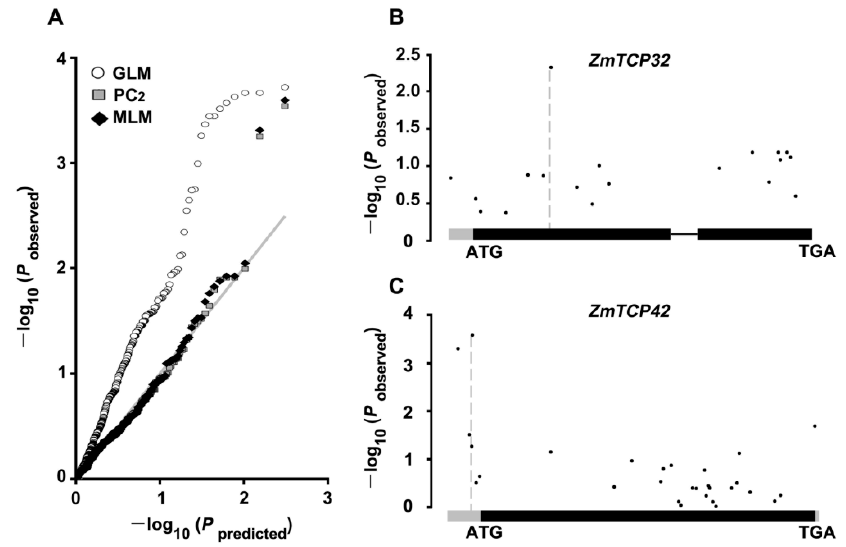
Figure 4. Association analysis of genetic variations in ZmTCP32 and ZmTCP42 with maize drought tolerance. ( A ) Quantile–quantile plots of the estimated –log10( p ) from the ZmTCP gene family-based association analysis, using three methods. The gray line is the expected line under the null distribution. The white square represents the observed p values using general linear model (GLM); the gray square represents the GLM model with the first two principal components (PC 2 ); the black diamond represents the observed p values using the mixed linear model (MLM) model incorporating both PC 2 and a Kinship matrix. ( B , C ) Schematic diagrams of ZmTCP32 ( B ) and ZmTCP42 ( C ), including the UTR (gray), intron (thin black line), and protein coding regions (thick black line), are presented in the x-axis. The p value is shown on a –log10 scale.